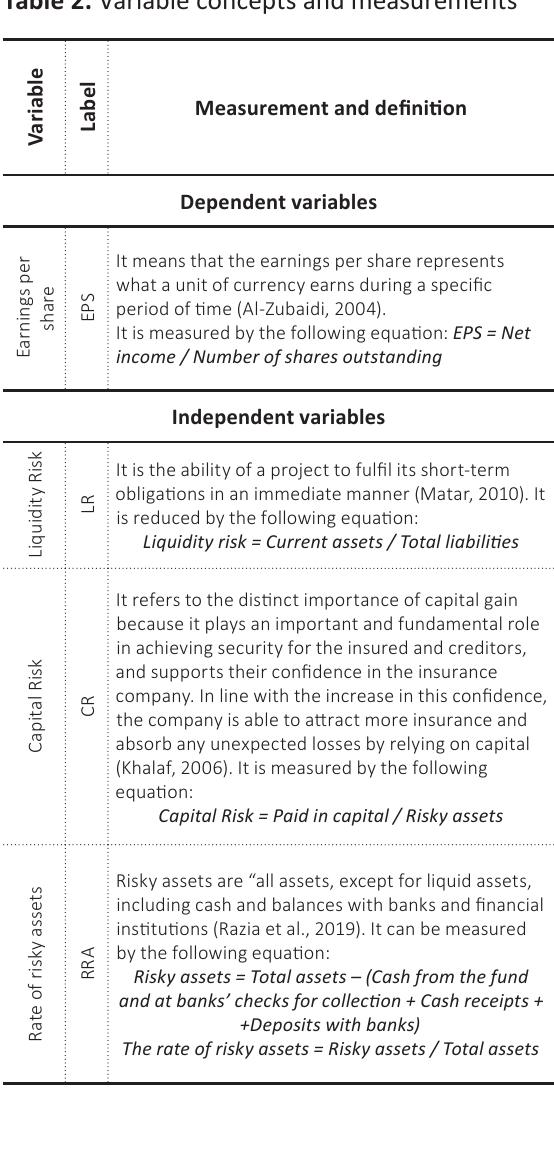
Table 2. Variable concepts and